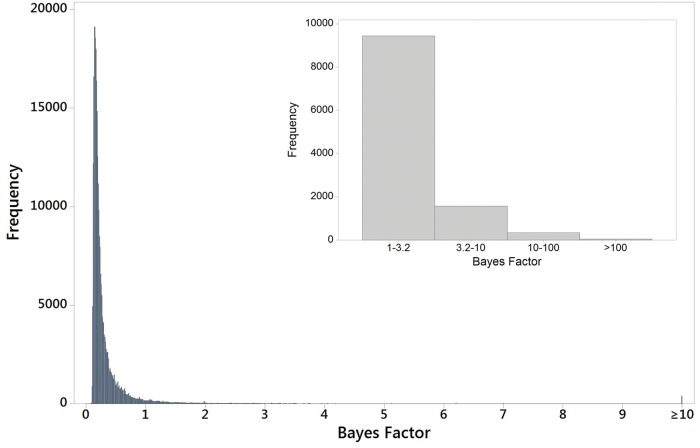
Distribution of Bayes factors from Bayenv 2 analyses of associations between SNPs and xeric/mesic habitats. The main histogram shows the distribution of Bayes factors obtained from Bayenv 2 analyses of 276,483 SNPs. The final histogram bin contains the 395 SNPs with Bayes factors ranging from 10 to 3.3 × 1048 (see Results). The insert histogram excludes Bayes factors <1, allowing clearer visualization of the distribution relative to cut-off points that are often used in the interpretation of Bayes factors (Kass and Raftery 1995).